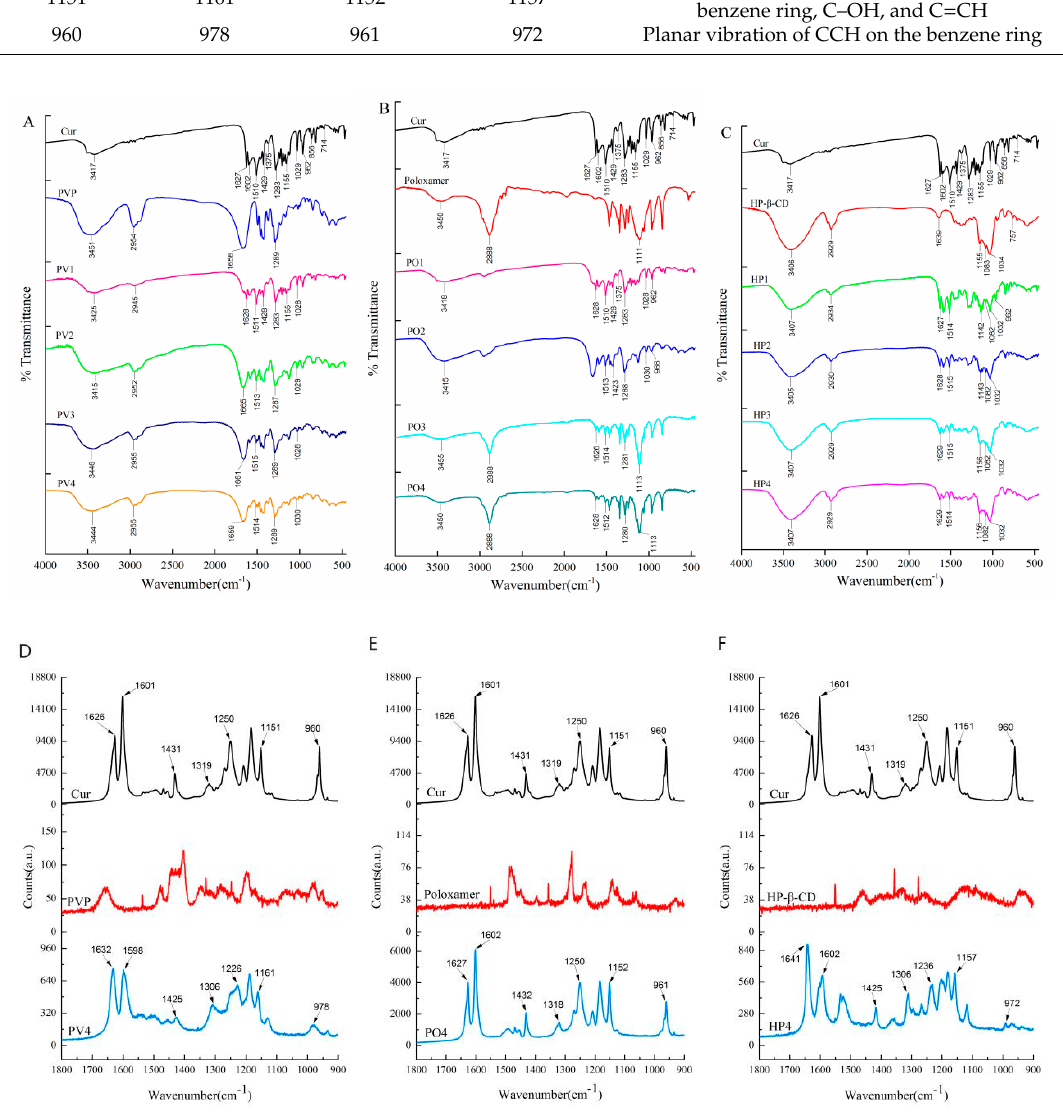
Figure 7. The ( A – C ) FTIR and ( D – F ) Raman spectrum of Curcumin and Curcumin solid dispersion.